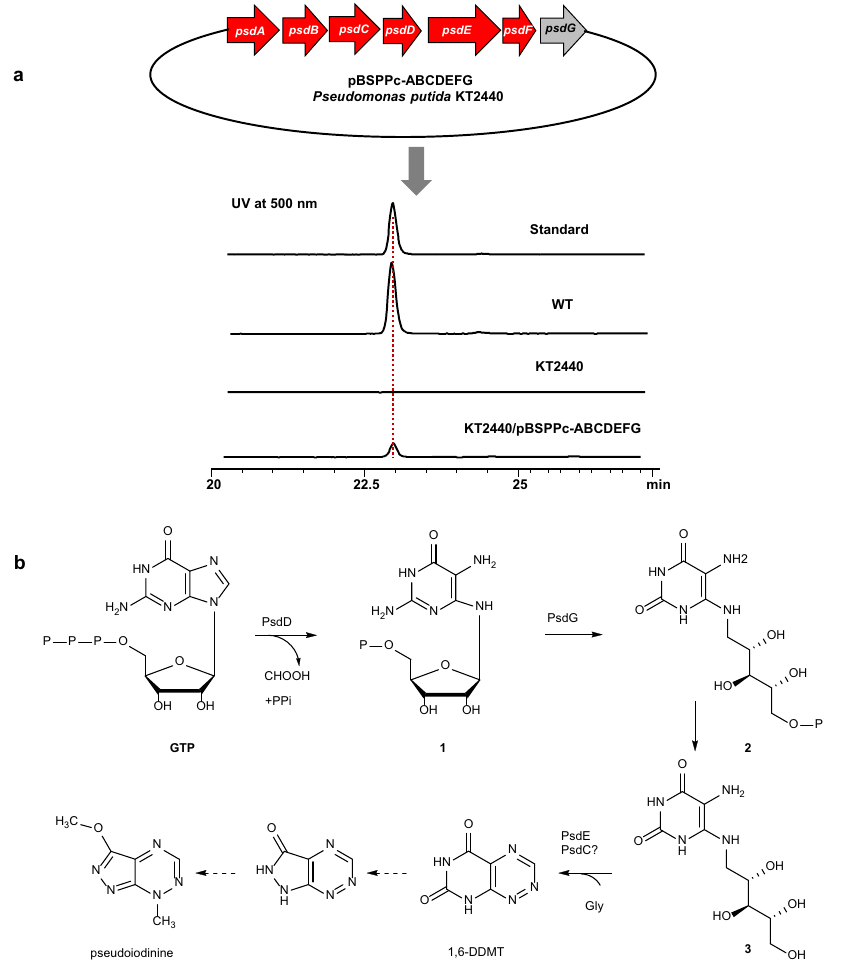
Fig. 4 | Heterologous expression of the psdABCDEFG operon in P. putida KT2440andproposedbiosyntheticrouteforpseudoiodininein P.mosselii 923. a Pseudoiodinine biosynthetic cluster in construct pBSPPc-ABCDEFG and HPLC analysis (Method B, detected at 500nm) of the fermentation extracts of WT, KT2440 and engineered heterologous expression strain and the standard sample (pseudoiodinine).Standard,pseudoiodinineisolatedfrom P.mosselii